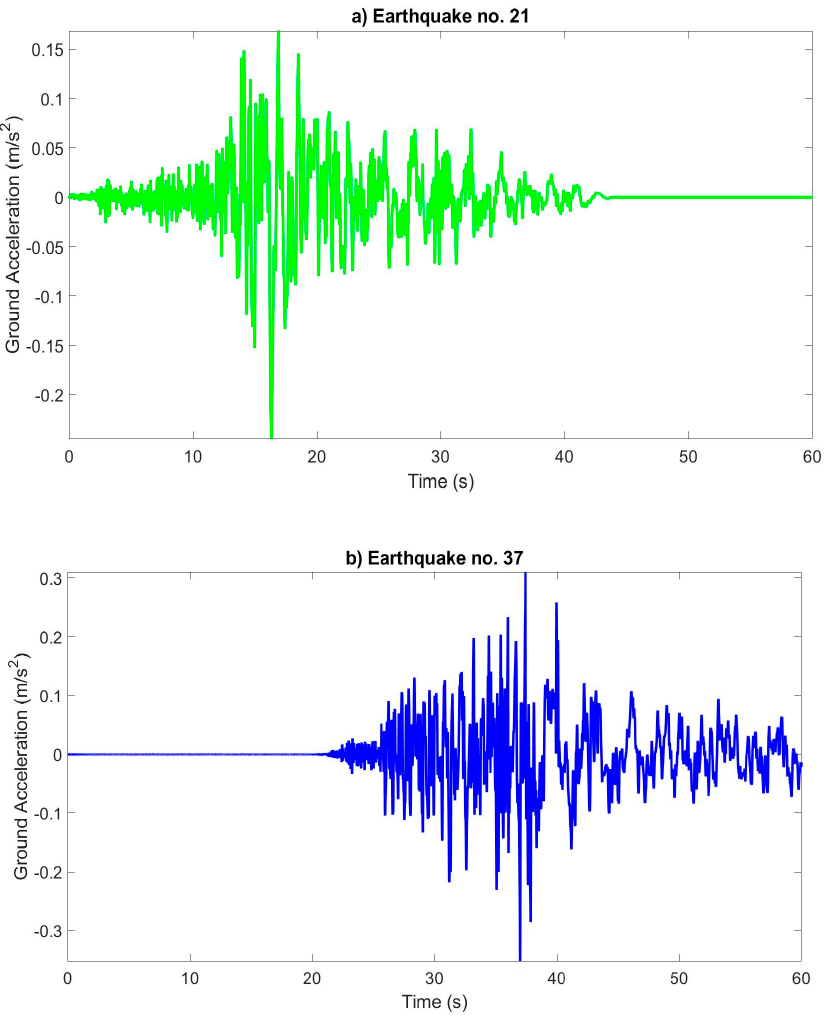
Figure 5. Two accelerograms of the FEMA P-695-FF record set: ( a ) earthquake no. 21; ( b ) earthquake no. 37.